Question: Briefly state, in one sentence, what is plotted here.
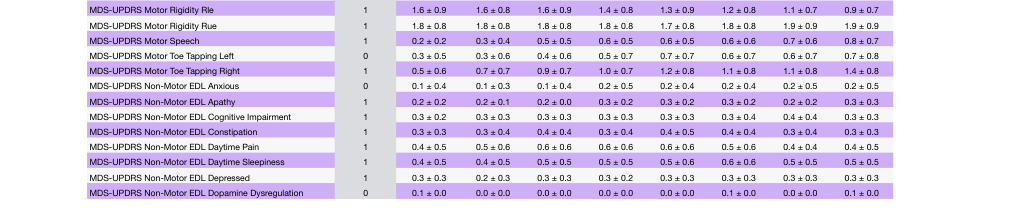
Answer: An example twin record for a single PD patient is shown, which reports the mean and standard deviation of the twins for that patient. A sample of static baseline information is given at the top of the record. A sample of longitudinal outcomes predicted by the model are supplied as rows, with columns indicating the time in months since baseline visit. The number of longitudinal records have been truncated.